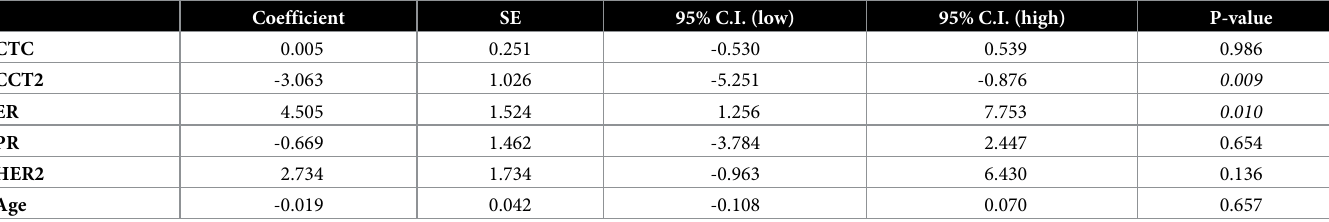
Table 3. Multiple linear regression for CCT2 tumor stain score and time gap, accounting for various variables.